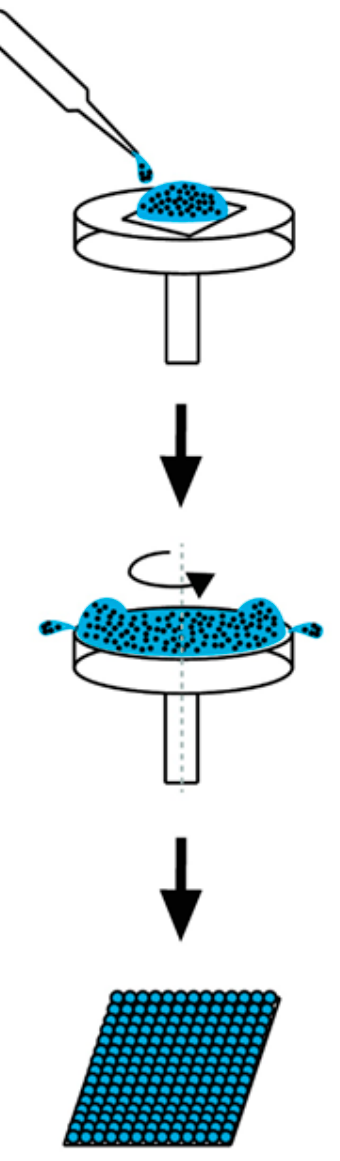
Figure 1. The schematic spin coating process.